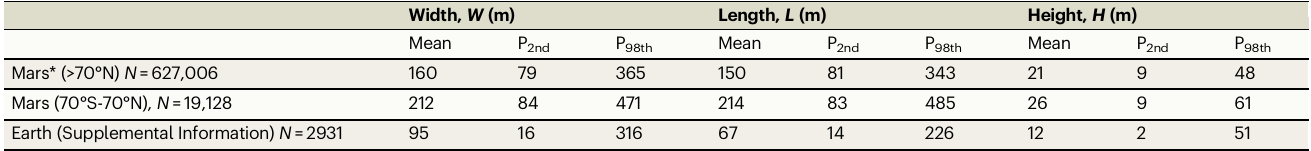
Table 1 | Summary of barchan morphometrics on Mars and comparison with Earth (rounded to nearest integer; P 2 and P 98 denote the 2nd and 98th percentiles, respectively) Width, W (m) Length, L (m) Height, H (m) Mean P